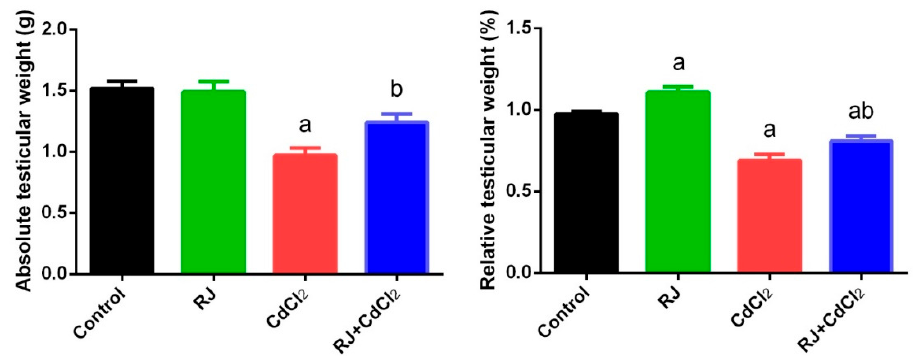
Figure 2. Effects of Royal jelly (RJ) administration on absolute and relative testicular weight of mice treated with cadmium chloride (CdCl 2 ) toxicity. All values are expressed as mean ± SEM (n = 7). a refers to a significant change from the control mice at p < 0.05; b refers to a significant change from the CdCl 2 -treated mice at p < 0.05, using Duncan’s post hoc test.